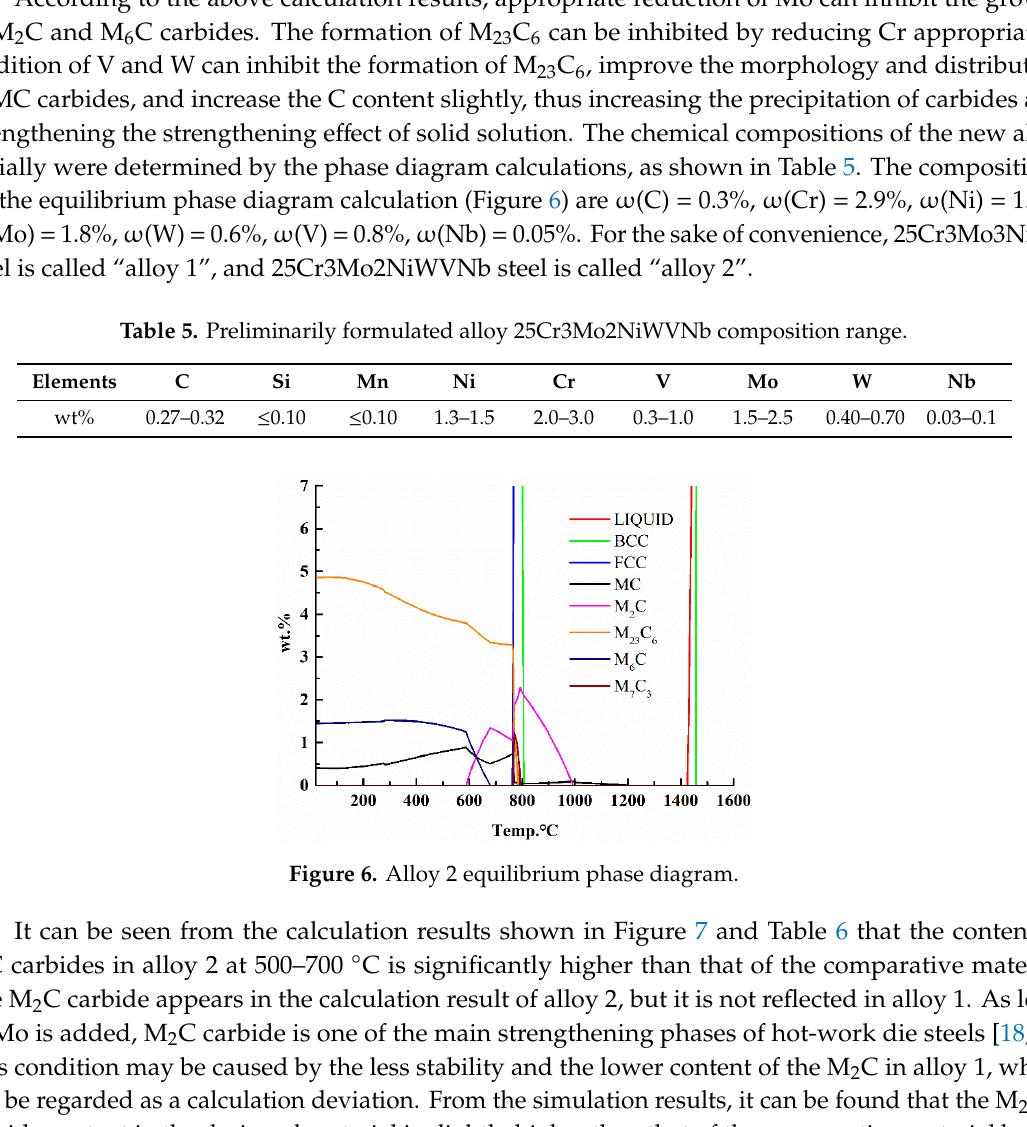
Table 6. Comparing the information calculated from the balance phase of alloy 1 and alloy